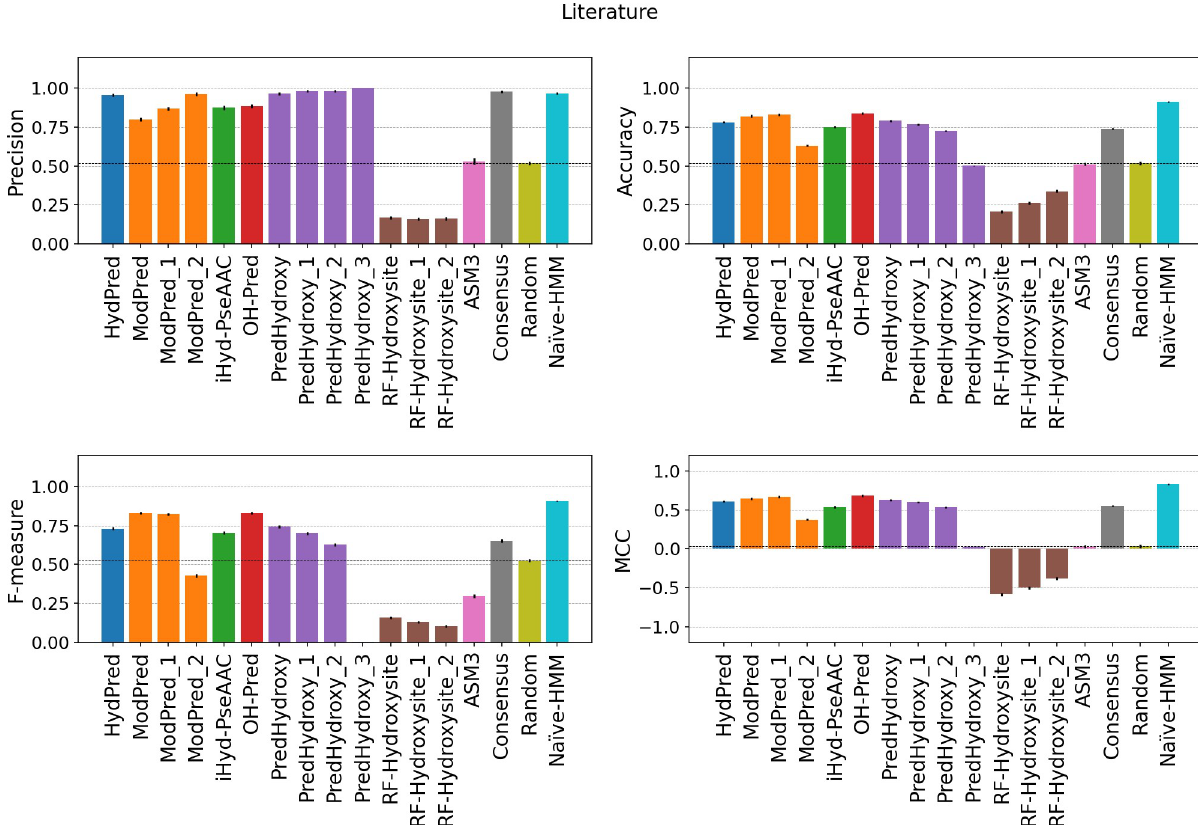
Fig 1. Performance on literature examples. The evaluation is performed only considering hydroxylated sites detected by single protein experiments (Literature dataset). Error bars are the standard deviation calculated over 1,000 replica sets. The consensus baseline method is the majority vote across all predictors. Suffix numbers in the method names indicate increasing quality threshold as defined by